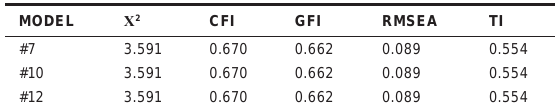
tABLe 4 Structural equation modelling outcome